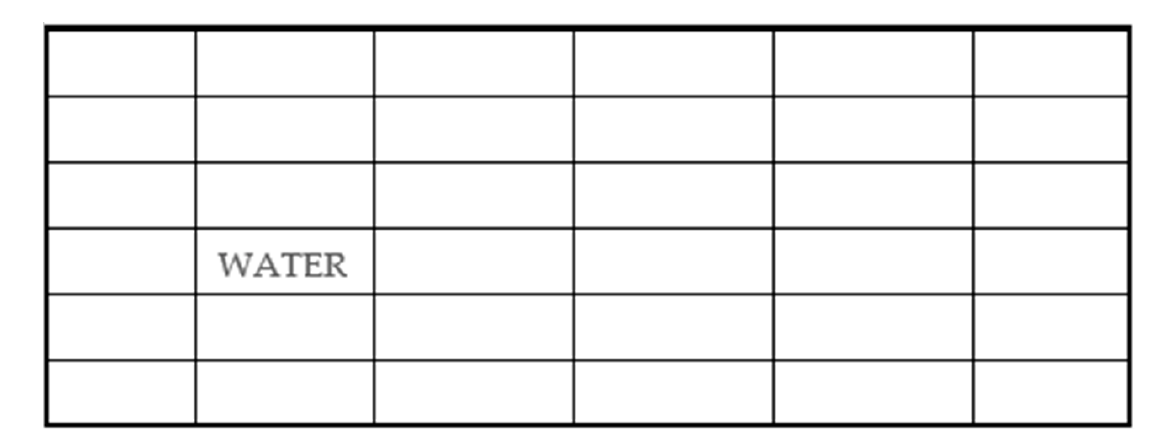
mem <x> in the past and retrieved again now (Equation (89)).